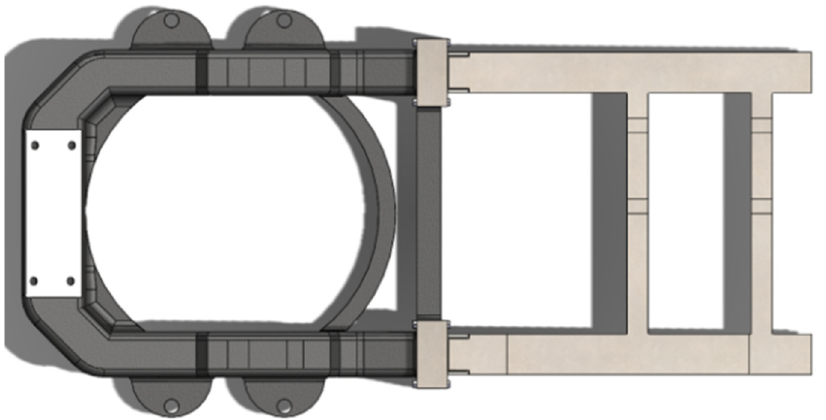
Figure 1. Top view of hybrid bedplate design [30].